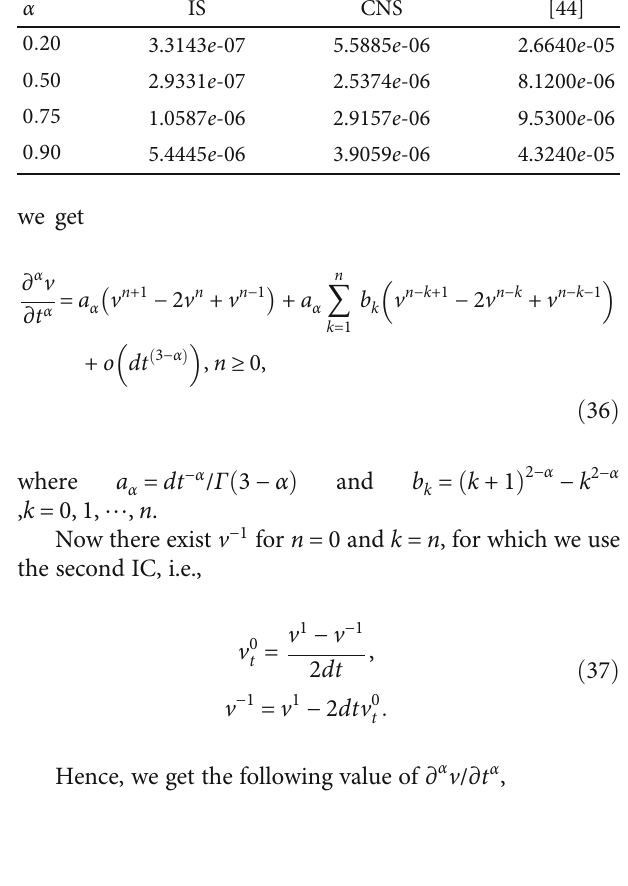
Table 4: Error norms and computational order for di ff erent time steps with c = 5 : 1, N = 50 and t = 1 for the Problem 4.